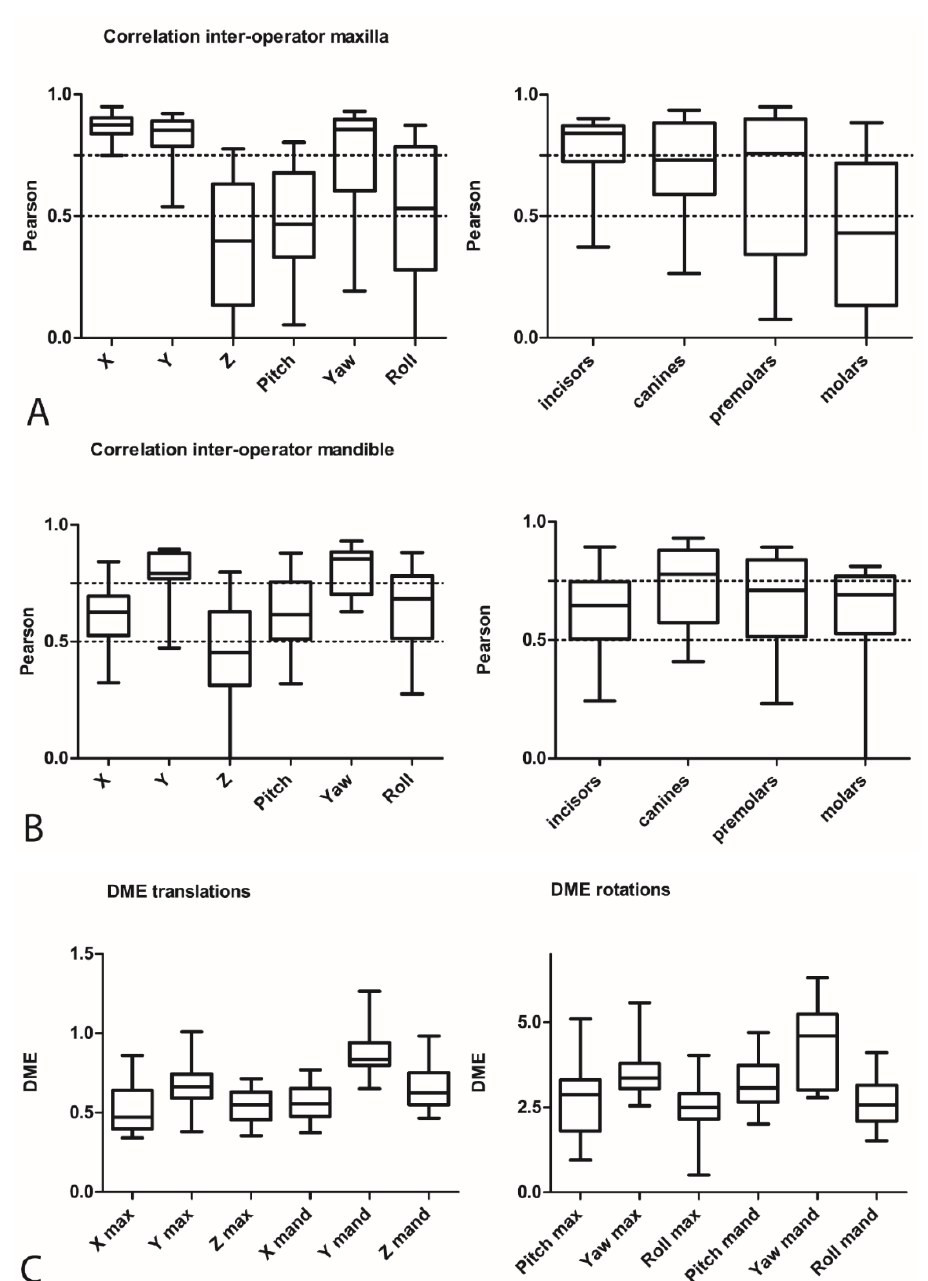
Figure 5. ( A ) Inter-operator correlations in the maxilla for rotations, translations, and tooth types. ( B ) Inter-operator correlations in the mandible for rotations, translations, and tooth types. ( C ) Inter- operator DME for all translational and rotational movements.